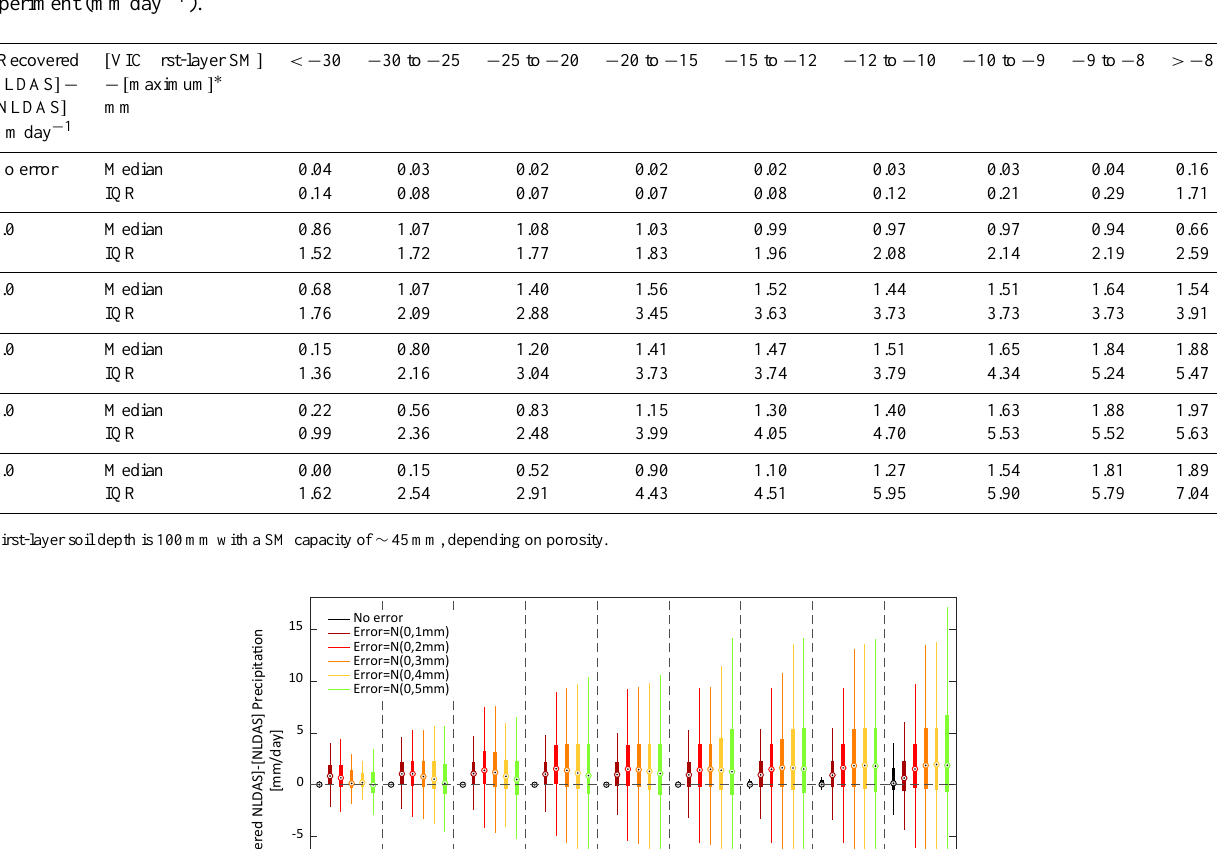
Table 2. Error statistics of recovered NLDAS based on (cid:49) SM (with added errors) conditioned on first-layer soil wetness for the idealized experiment (mmday − 1 ).